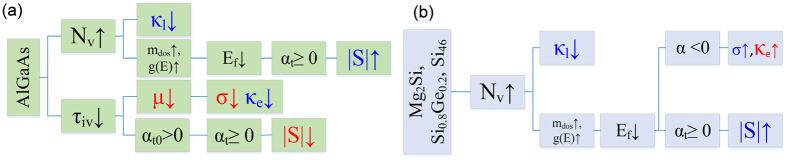
Dominant valleytronics effects are shown for AlxGa1−xAs (a), Mg2Si, Si0.8Ge0.2, and Si46-VIII (b). The blue letters and arrows indicate the beneficial effects while the red letters and arrows indicate the detrimental effects.